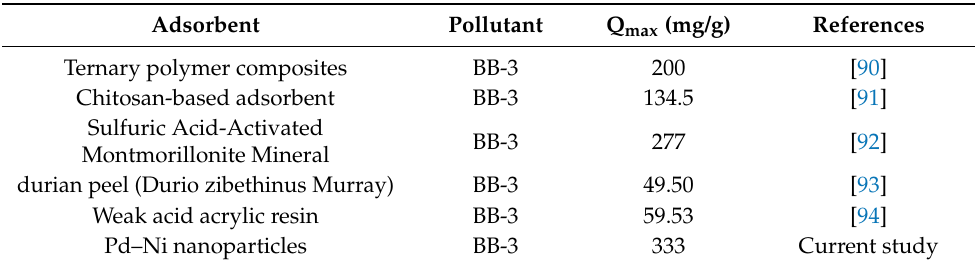
Table 6. Comparison of adsorption capacities of various adsorbents for the removal of BB-3 within our current